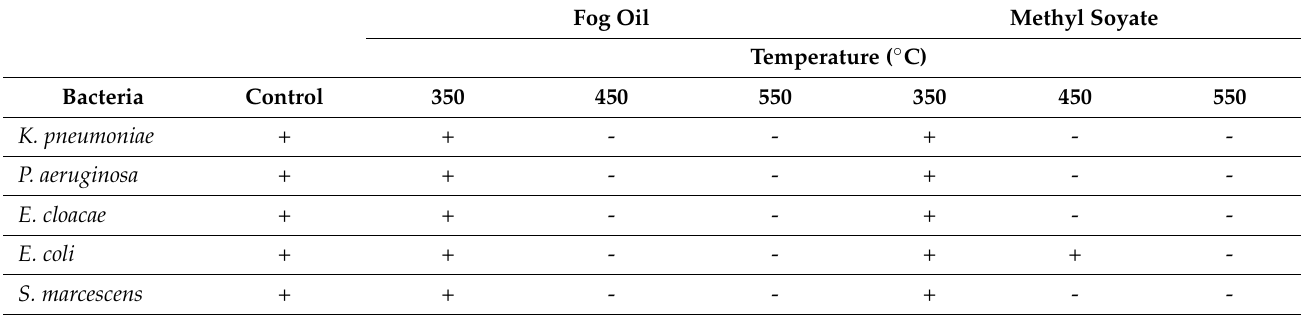
Table 11. Results of exposure of bacteria to oil aerosols.